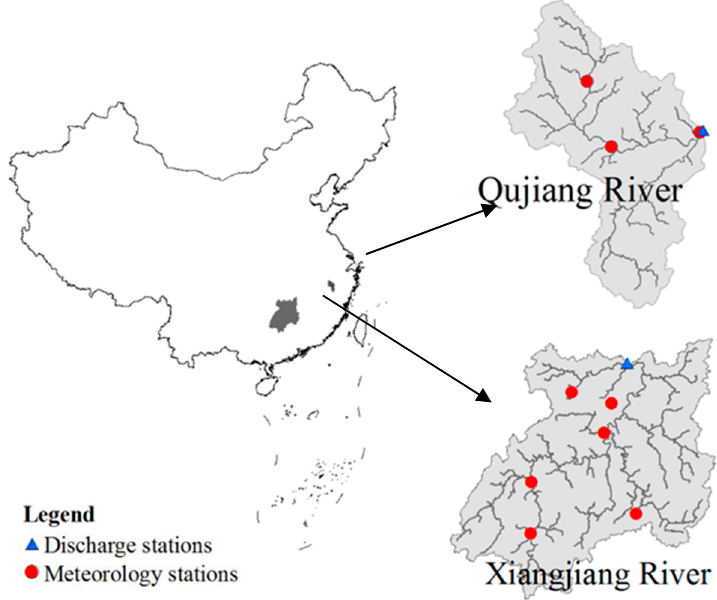
Figure 1. Location of the study areas and observation stations.